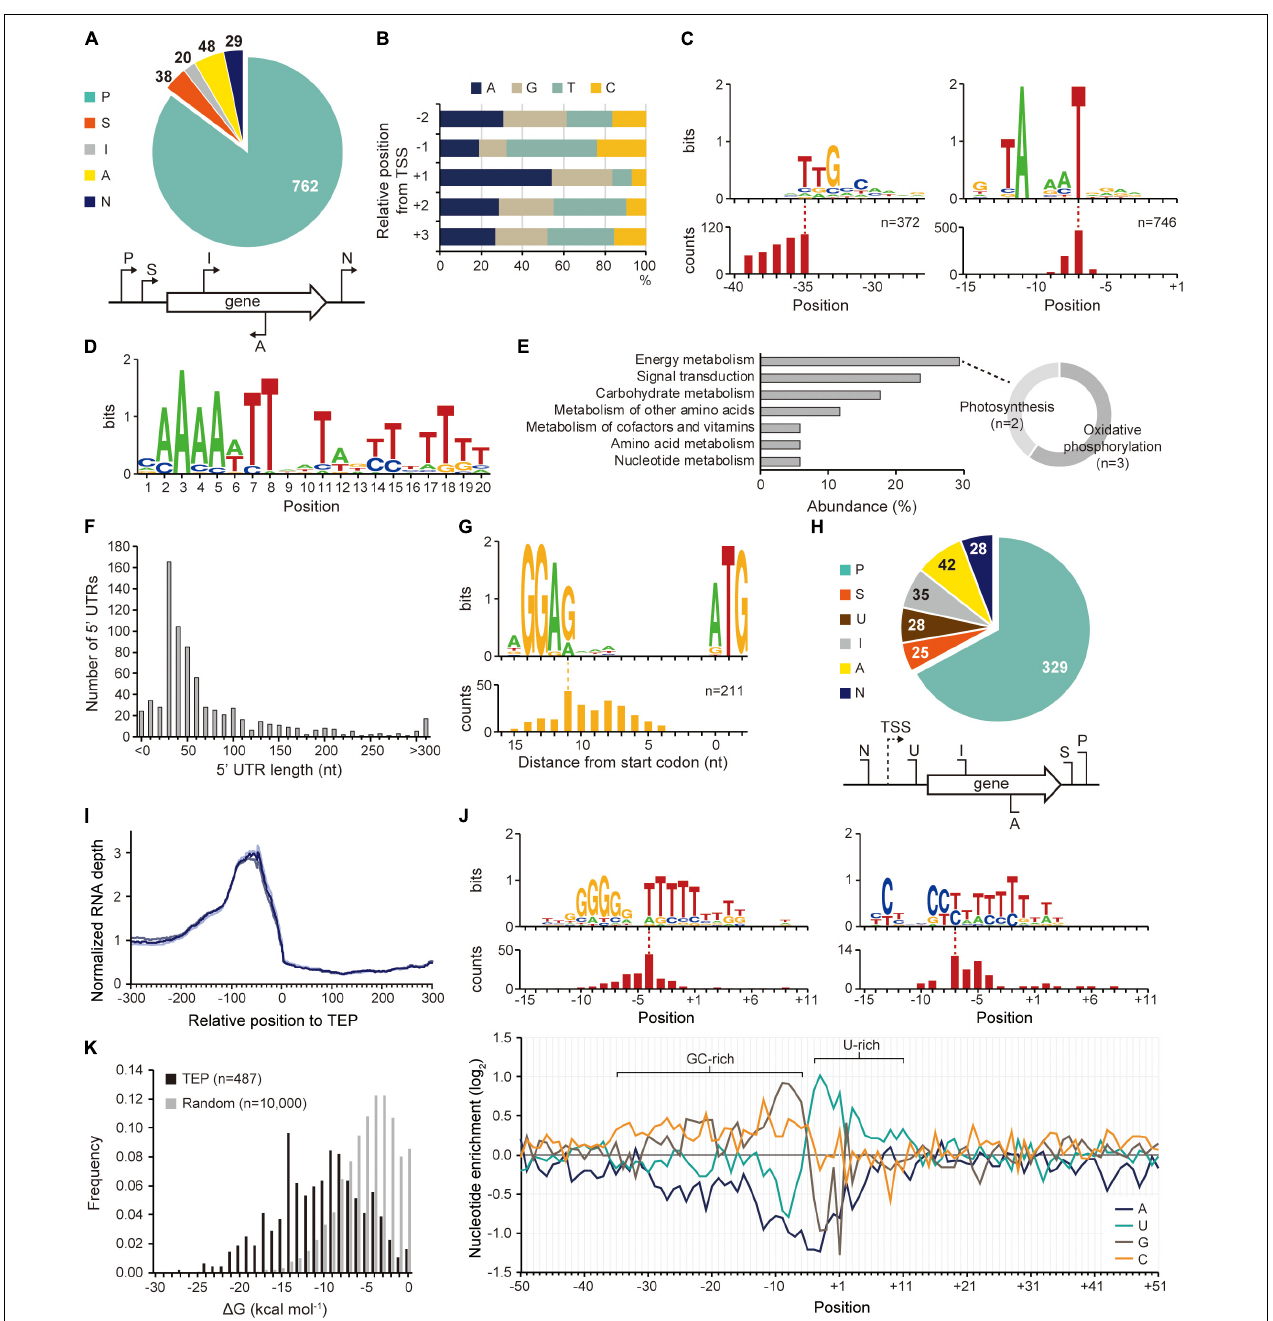
FIGURE 2 | Identification of transcription start site (TSS), transcript 3 (cid:48) -end position (TEP), and regulatory elements involved in transcription regulation. (A) TSS categorization by their relative positions to adjacent genes. (B) The nucleotide frequency calculated near the TSSs shows purine preference at TSS (+ 1 position) and pyrimidine preference at – 1 position. (C) Conserved – 10 and – 35 promoter motifs. The relative position of the motif to the TSS is represented at the bottom. (D) The Fur binding motif found at the upstream regions of Synechocystis sp. PCC 7338-specific genes. (E) The KEGG pathway analysis of the genes having the Fur motif. The sub-categories of the category with the highest abundance (energy metabolism category) were indicated as a doughnut chart. (F) The length distribution of 5 (cid:48) -untranslated region (5 (cid:48) -UTR). (G) The ribosome binding site (RBS) sequence detected at 5 (cid:48) -UTR. The relative position of the RBS to the start codon is represented at the bottom. (H) TEP categorization by their relative positions to adjacent genes. Keys: P, primary TEP; S, secondary TEP; U, 5 (cid:48) -UTR TEP; I, internal TEP; A, antisense TEP; N, intergenic TEP. (I) RNA expression profiles near the identified TEPs. Each line shows each result from triplicate RNA-seq data. (J) The top panel shows conserved sequences detected near the TEPs. The relative positions of the sequences to the TEPs are represented at the bottom of each sequence. The bottom panel shows nucleotide enrichment calculated in ± 50 nt sequences from TEPs. The ratio of each nucleotide at each position was normalized with those of randomly selected intergenic positions ( n = 10,000). (K) The folding energy was calculated at upstream sequences of TEPs or at randomly selected intergenic positions.